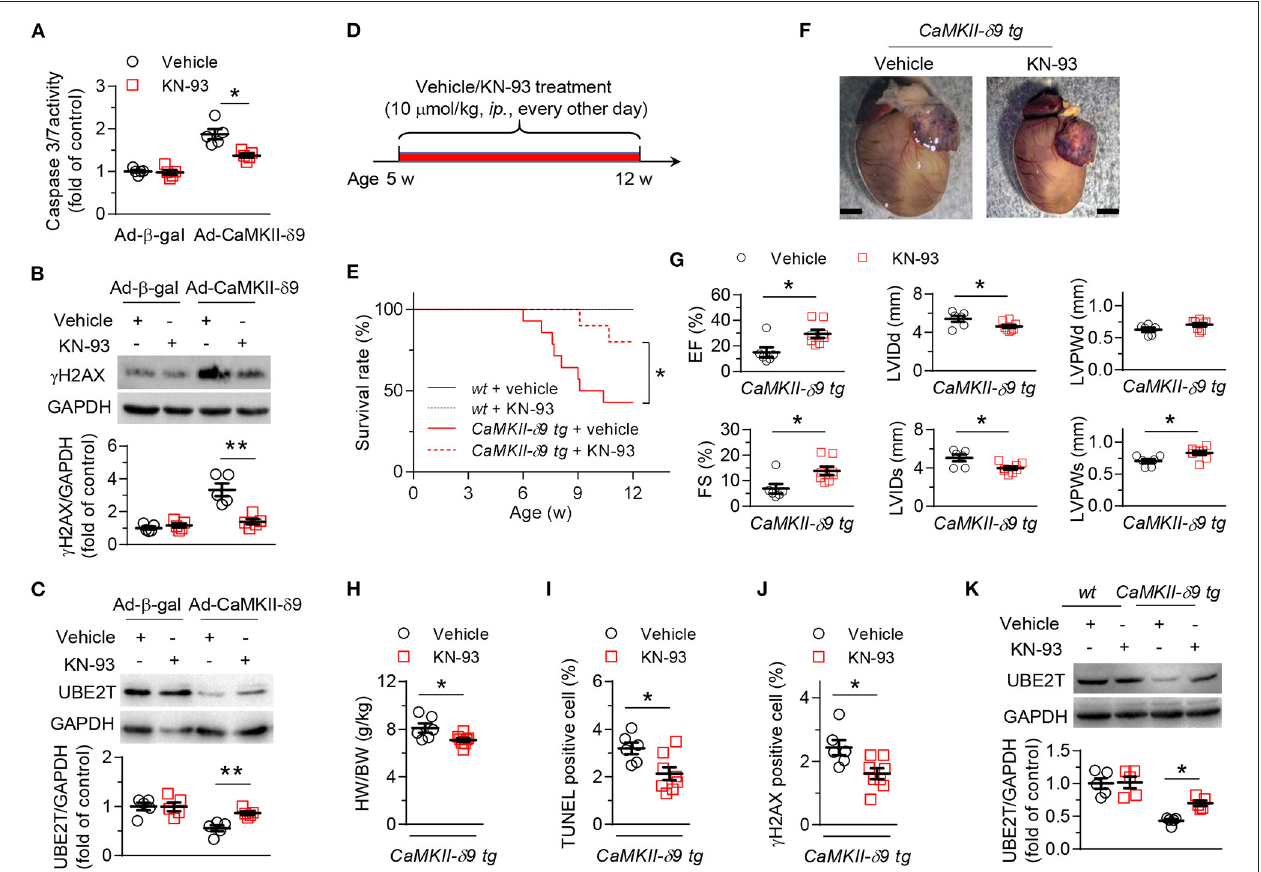
FIGURE 1 | KN-93 treatment prevents CaMKII- δ 9-induced cardiomyopathy and heart failure. (A–C) , Cell viability assayed by caspase 3/7 activity (A) and representative western blots and statistical data showing the levels of γ H2AX (B) and UBE2T (C) in NRVMs infected with Ad- β -gal or Ad-CaMKII- δ 9 with or without KN-93 treatment (5 µ M) ( n = 5). (D) Experimental protocol for in vivo KN-93 treatment in CaMKII- d 9 tg mice. The mice were treated with KN-93 (10 µ mol/kg, i.p. ) every other day from 5 to 12 weeks of age. (E) Kaplan-Meier survival curves of wt and CaMKII- δ 9 tg mice with or without KN-93 treatment ( n = 8 for wt vehicle, n = 7 for wt KN-93, n = 14 for CaMKII- δ 9 tg vehicle, n = 10 for CaMKII- δ 9 tg KN-93). (F–J) Gross morphology of the hearts (F) , statistical data of the left ventricle echocardiography (G) , ratio of heart weight to body weight (H) , and statistical data of TUNEL (I) and γ H2AX (J) staining of the hearts from CaMKII- δ 9 tg mice with or without KN-93 treatment. EF, ejection fraction; FS, fractional shortening; LVIDd and LVIDs, diastolic and systolic left ventricular internal diameter; LVPWd and LVPWs, diastolic and systolic left ventricular posterior wall thickness. Scale bar, 2mm ( n = 6 for vehicle, n = 8 for KN-93). (K) Representative western blots and statistical data showing the levels of UBE2T from the hearts of wt and CaMKII- δ 9 tg mice with or without KN-93 treatment ( n = 5). Data are mean ± S.E.M. * P < 0.05, ** P < 0.01; two-way ANOVA (A–C,K) , log-rank (Mantel-Cox) test, or Student’s t -test (E,G–J)